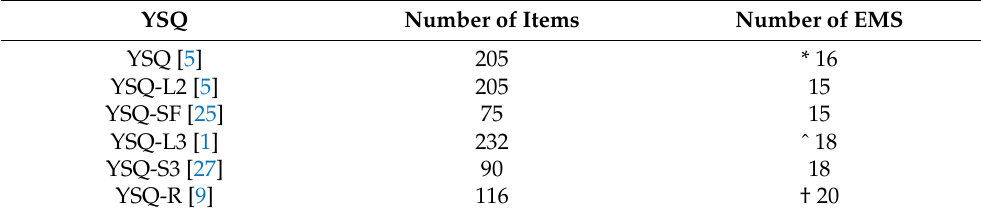
Table 2. Number of Items and Early Maladaptive Schemas (EMS) in the Various Versions of the Young Schema Questionnaire (YSQ). YSQ Number of Items Number of EMS YSQ [5] 205 * 16 YSQ-L2 [5] 205 15 YSQ-SF [25] 75 15 YSQ-L3 [1] 232 ˆ 18 YSQ-S3 [27] 90